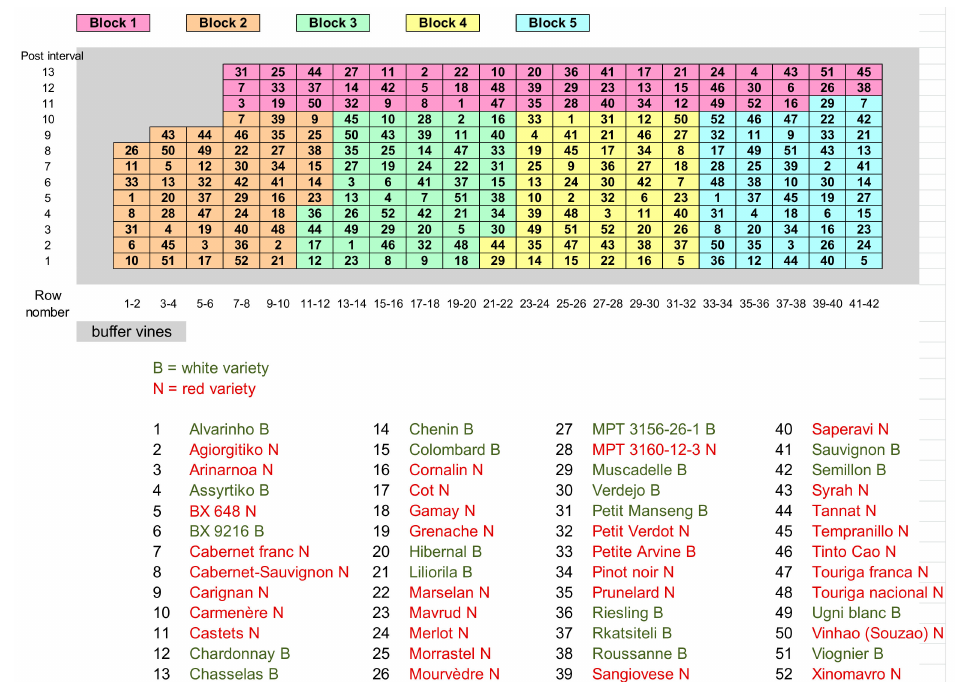
Figure 6. Layout of the 52 varieties planted in the VitAdapt experiment, with five replicates per variety and 10 vines per replicate.